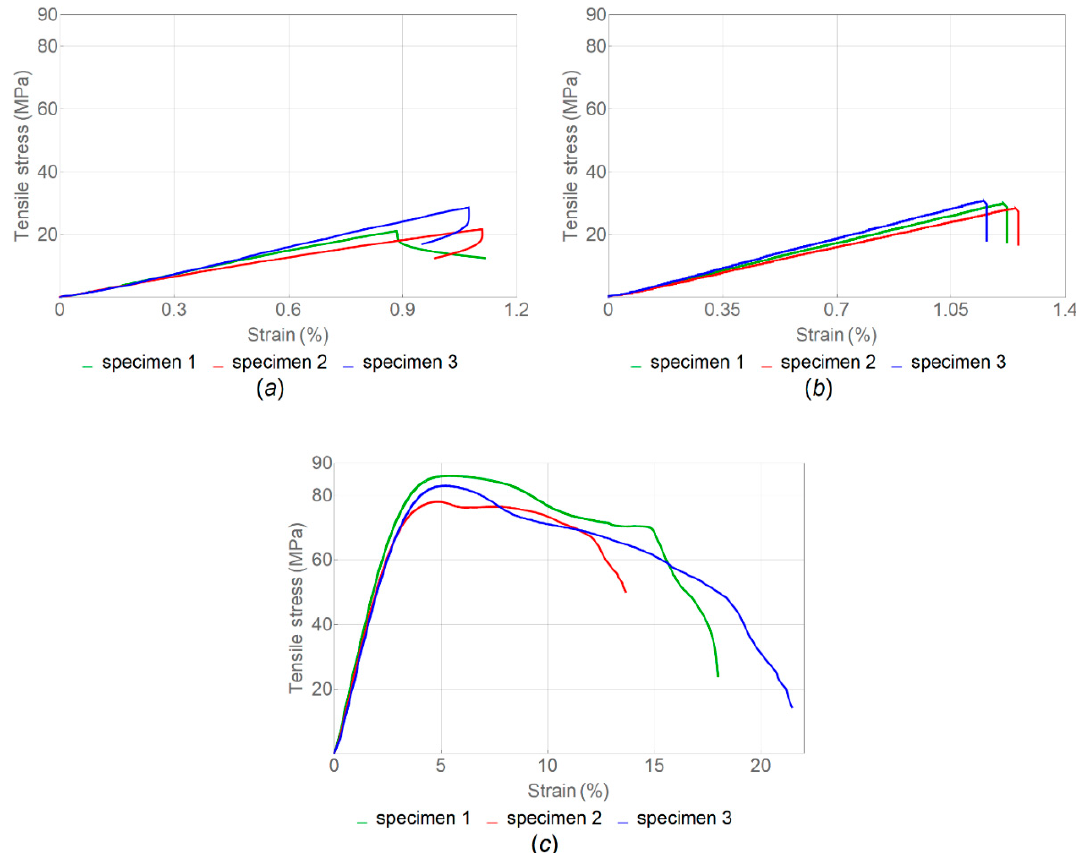
Figure 5. Stress–strain curve for tension load of samples without heat treatment with different infill angle α : ( a ) 45 ◦ ; ( b ) 90 ◦ ; and ( c ) 180 ◦ (nozzle diameter, 0.6